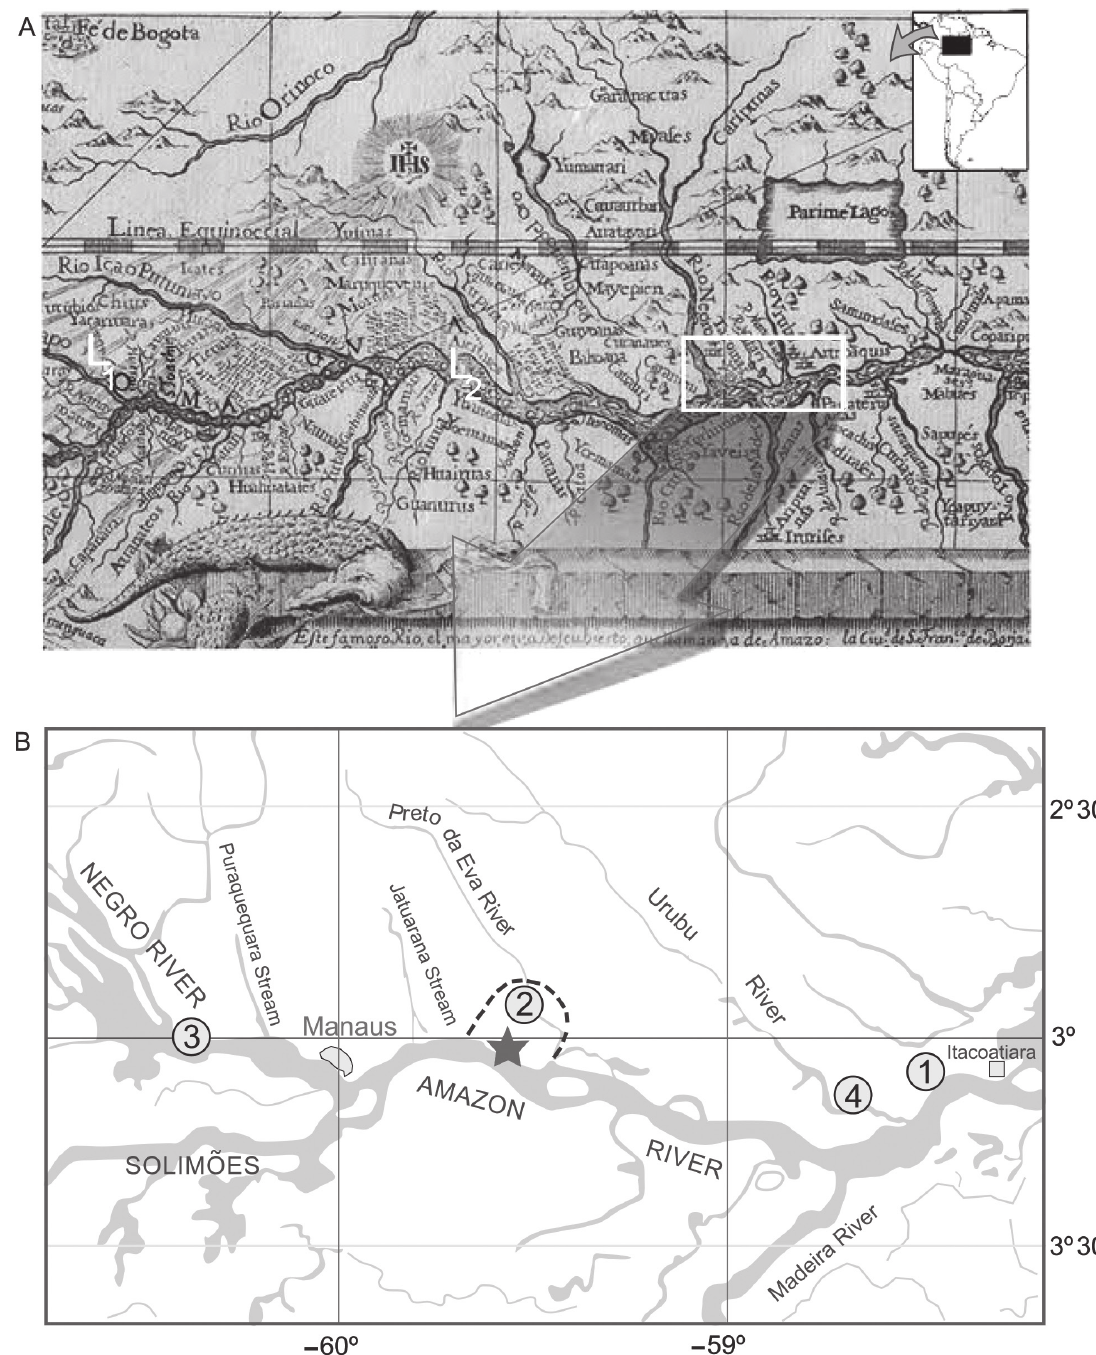
Fig. 1 - Ancient and modern maps of portions of the Amazon region. A , Section of Fritz’s Map of 1691 and engraved at Quito in 1707. L1 and L2 make the limits of the Omaguas lands from the mouth of Napo River, close to the mission of San Joaquin, in Peru, until the mouth of Jurua River, in Brazil. B , Part of an Amazonas State map indicating key sites: 1 , where Fritz learned about the tremor for the first time; 2 , estimated epicenter of the 1690 event and the most affected area - dashed line; 3 , location of the Taromas’ Village whose residents felt the tremor; 4 , the Indian Village on the bank of the Urubu River which overflowed according to father